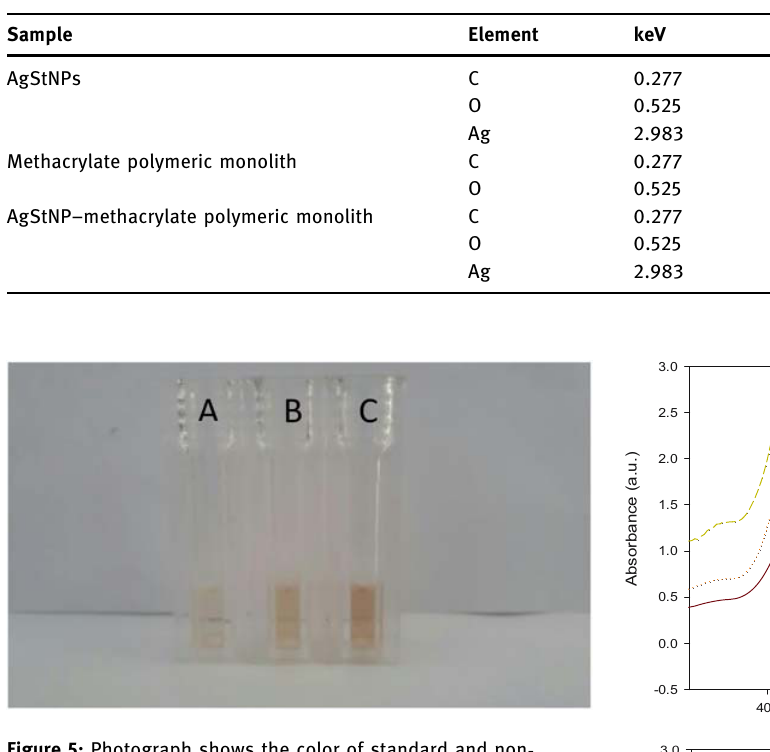
Figure 5: Photograph shows the color of standard and non - processed Hb ( A ) , preconcentrated Hb using bare organic monolith ( B ) , and preconcentrated Hb using AgStNP – methacrylate polymeric monolith ( C ) .